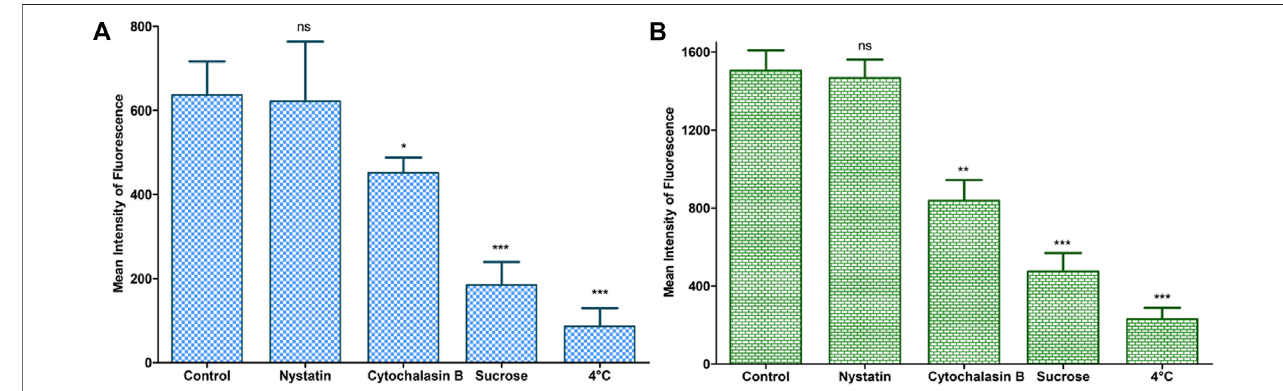
FIGURE 9 | Study of endocytic mechanistic pathways during cellular uptake of LNVs in A549 (A) and Calu 3 (B) cell lines using a fl ow cytometer. Data represent mean ± SD values ( n (cid:2) 3). The asterisks represent statistically signi fi cant difference (*** p < 0.0001, ** p < 0.005, * p < 0.05), while “ ns ” indicates an insigni fi cant ( p > 0.05) difference between the control A549 and the tested Calu 3 cells groups.